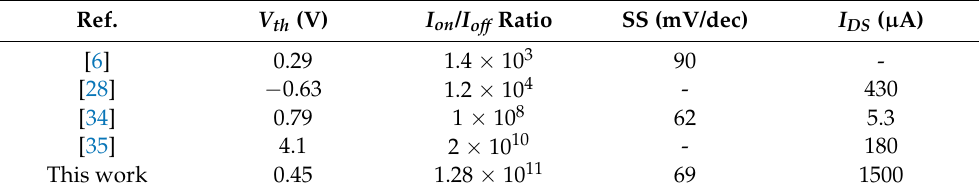
Table 2. Comparison of electrical